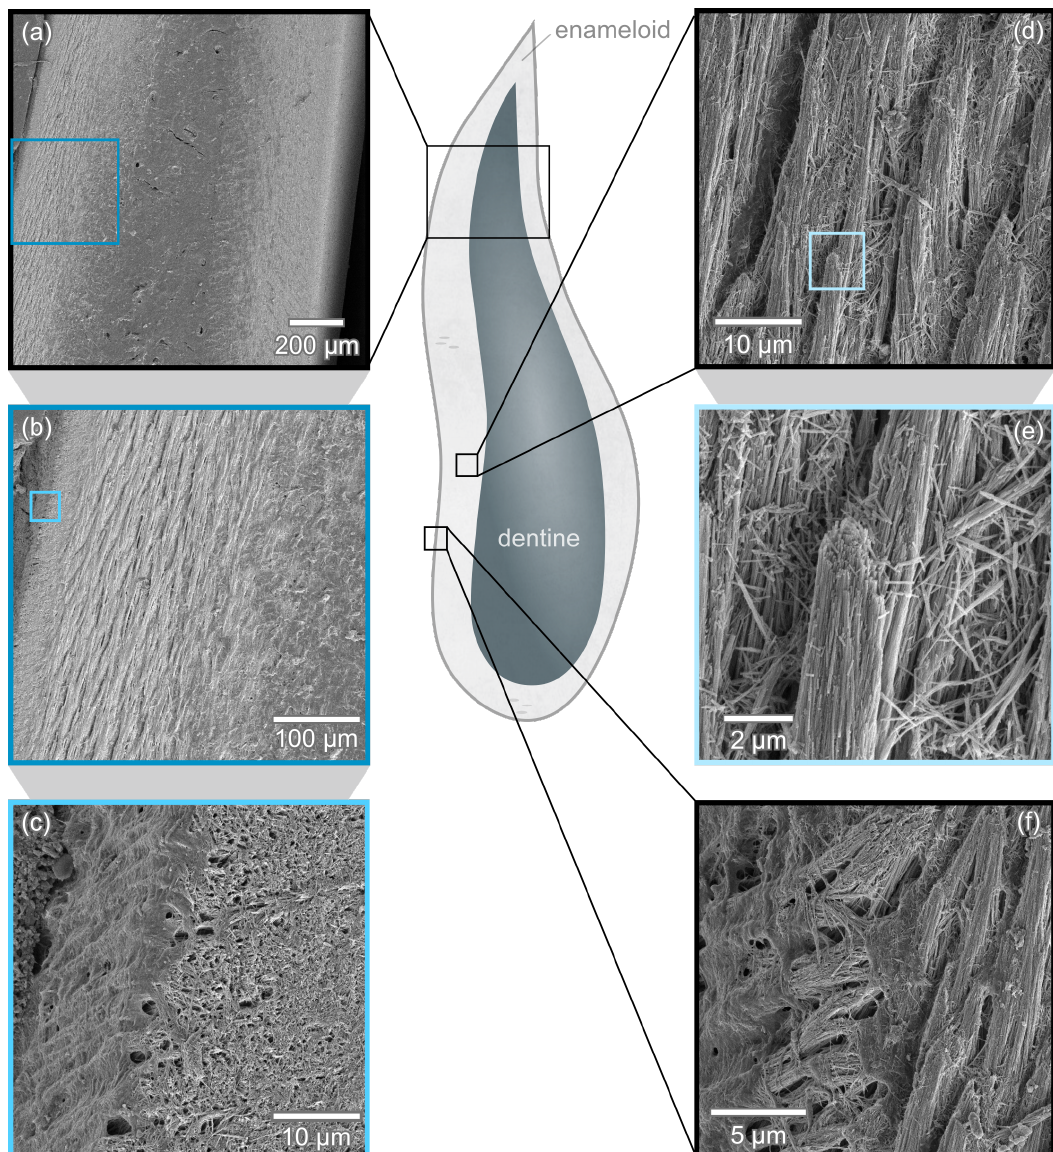
Figure 3. I. oxyrinchus tooth in longitudinal section. The enameloid cover is characteristically layered as seen in ( a , b ). Zooming into the outer enameloid, a densely packed outer layer is found in the top part of the tooth ( c ) while in the lower part, distinct circumferential bundles are apparent ( f ). ( d ) The outer enameloid surrounds a layer of parallel aligned crystal bundles. ( e ) Magnified view of the broken tip of a bundle from ( d